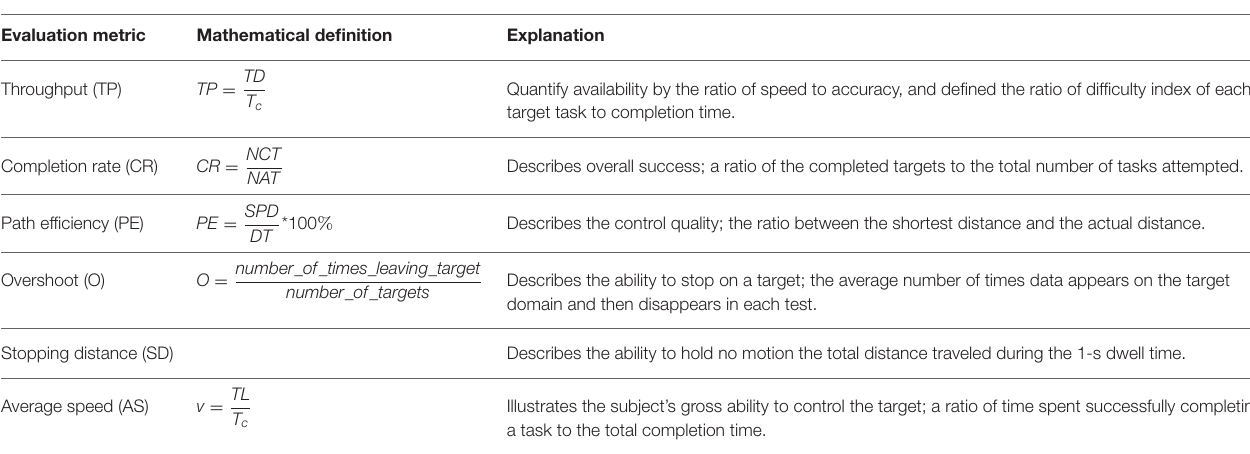
TABLE 4 | The commonly used real-time performance